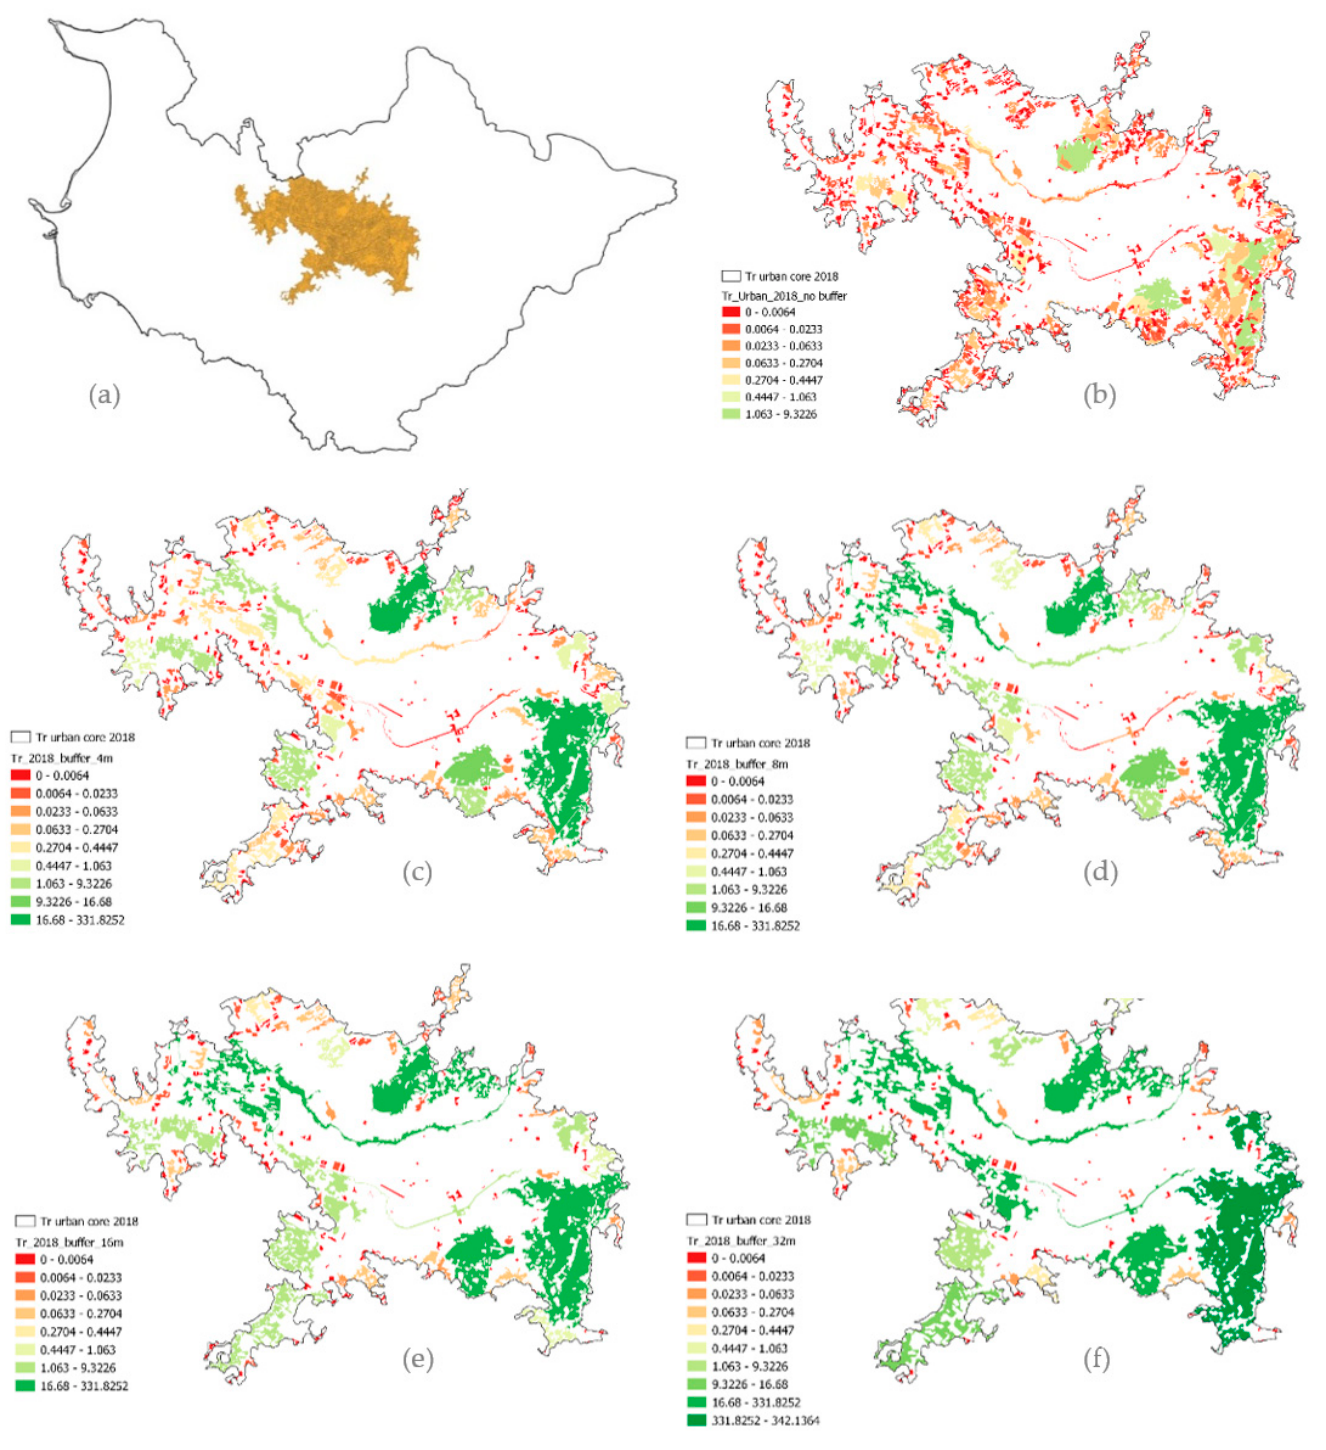
Figure 8. m eff analysis applied on ( a ) the Tirana case based on buffer distances of ( b ) 0 m, ( c ) 4 m, ( d ) 8 m, ( e ) 16 m, and ( f ) 32 m based on UA of 2018 records. Table 2. Results of m eff for 2012 and 2018.